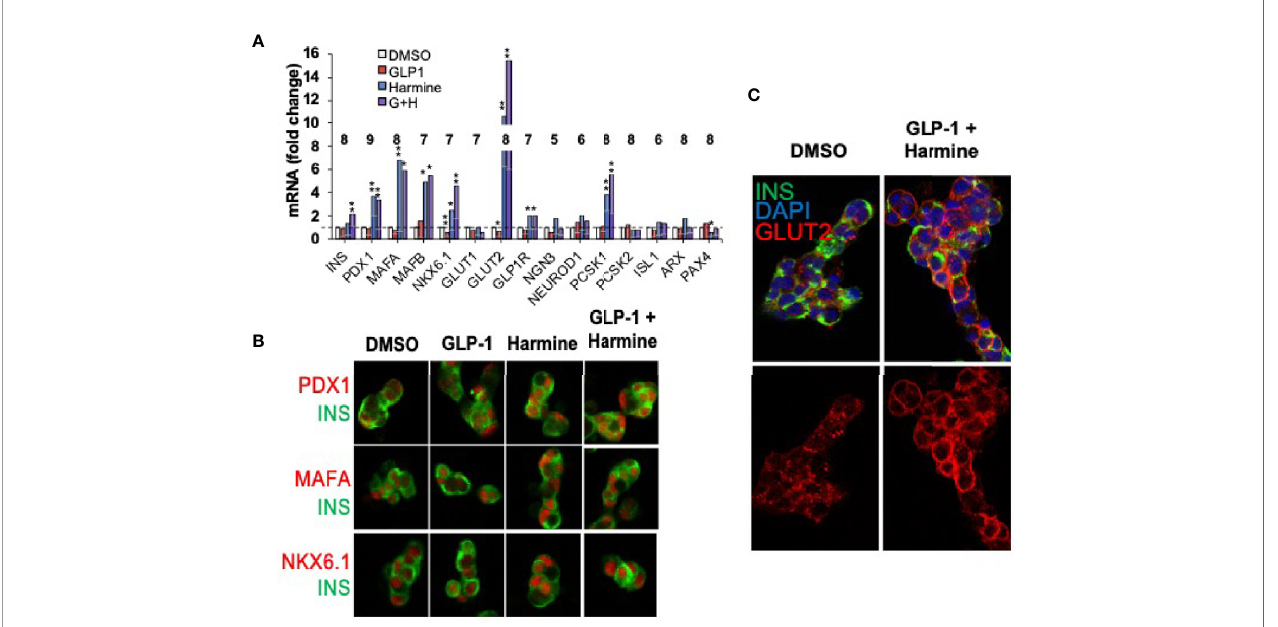
FIGURE 8 | Harmine Alone and In Combination With GLP1 Enhances Human Beta Cell Differentiation. (A) Q-PCR gene expression studies on human islets treated with vehicle (DMSO), harmine alone, GLP1 alone or the combination. Note that harmine alone and in combination with GLP1, increases expression of canonical beta cell transcription factors and differentiation markers. The numbers within the bars represent the number of different human islet batches tested. (B) Immunocytochemistry showing that key beta cell transcription factors (red) are present, as expected, in human beta cells (green), and increase in abundance following harmine or harmine-GLP1 treatment. (C) The glucose transporter, GLUT2, increases in abundance in human beta cells and appears in the cell membrane with the harmine-GLP1 combination. Reproduced with permission from (29), which contains complete details. *p < 0.05, **p <